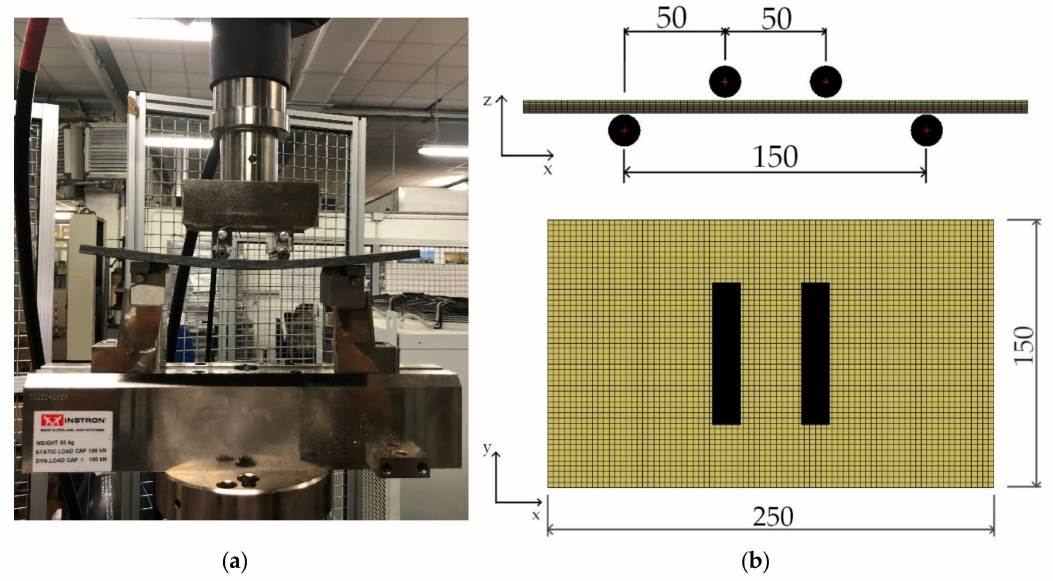
Figure 1. Four-point bending test: ( a ) experimental setup; ( b ) numerical